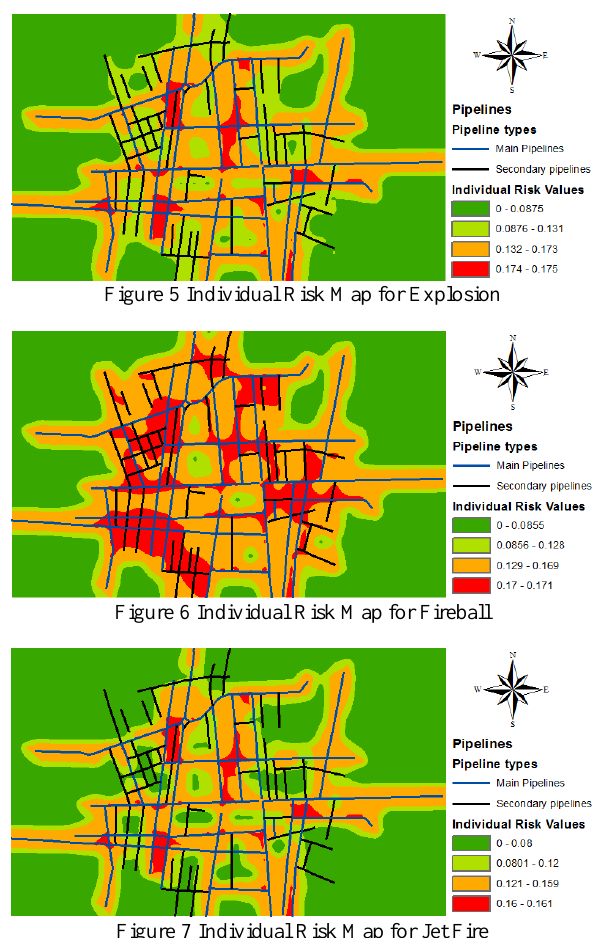
Figure 7 Individual Risk Map for Jet